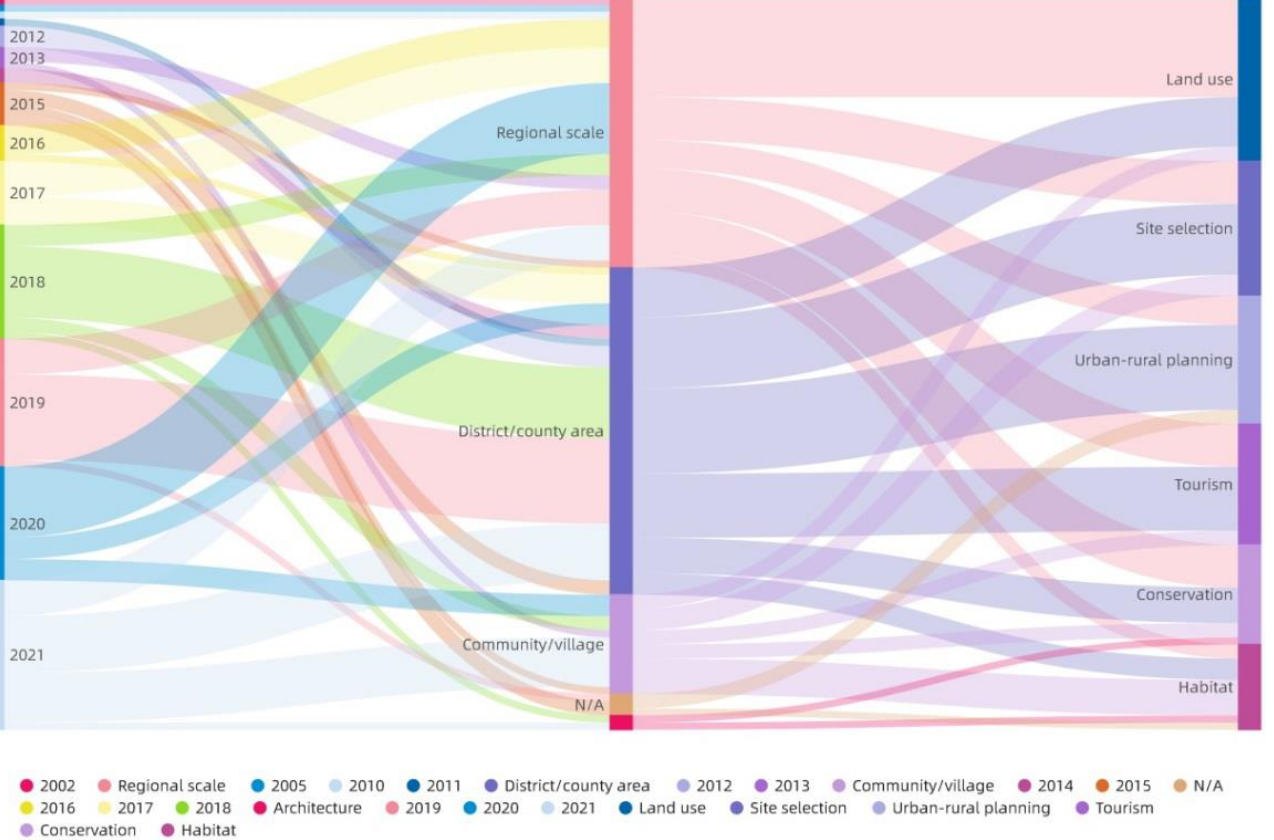
Figure 7. Sankey diagram of year, unit range, and research topic distribution.